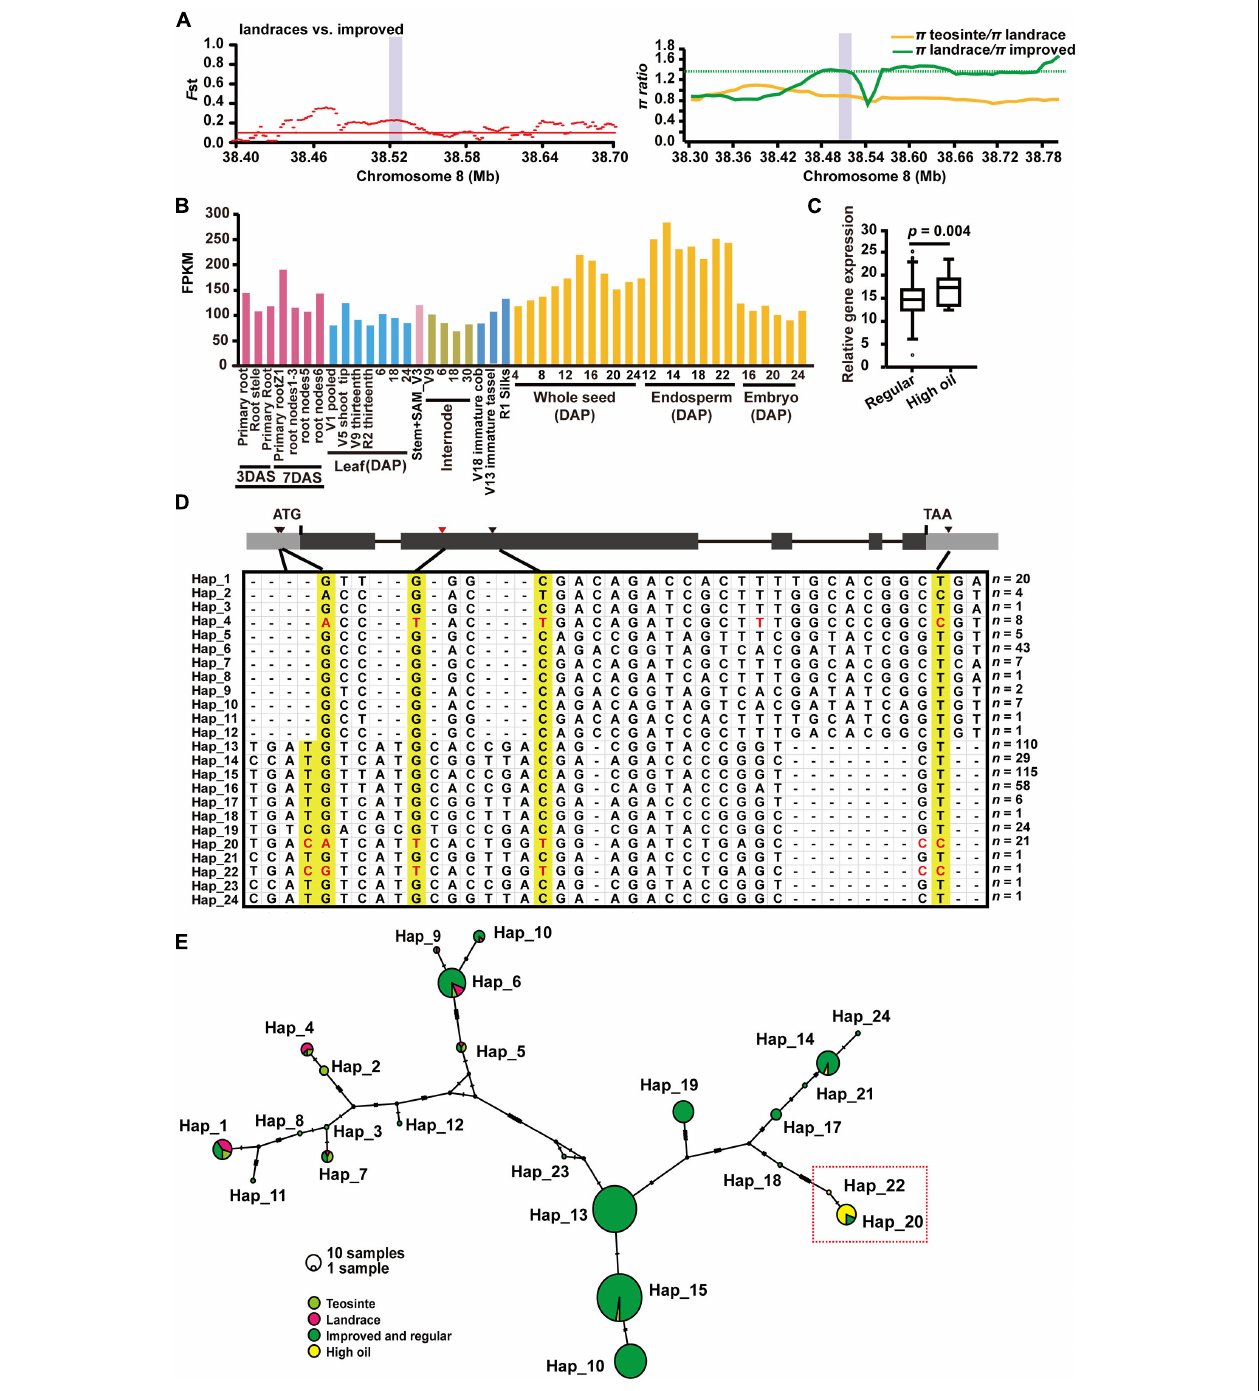
FIGURE 6 | ZmSec23a is selected during maize improvement and is strongly associated with seed oil content. (A) Fst (left) and π (right) values in landraces and improved cultivators across the 0.3-Mb and 0.48-Mb genomic regions surrounding ZmSec23a , respectively, which is indicated by the purple bar. (B) The spatiotemporal expression profile of ZmSec23a. (C) Gene expression analysis of ZmSec23a in high oil lines and regular materials. Statistical differences between regular materials and high oil lines were calculated by a two-tailed Student’s t -test ( p < 0.05). For the box, the central line indicates the median, and the box bounds mean the 25th and 75th percentiles. (D) Haplotype analysis of ZmSec23a among teosintes (20), landraces (22), improved lines (403), and high oil lines (23). Yellow colors denote the selected alleles of the ZmSec23a gene in maize improved high oil germplasms. (E) Genetic relatedness of ZmSec23a haplotypes based on the median-joining network constructed using PopART version 1.7. Each haplotype is represented by a circle, with its size proportional to the number of maize lines within it. Light green, teosintes; magenta, landraces; dark green, improved and regular cultivars; yellow, high oil materials.